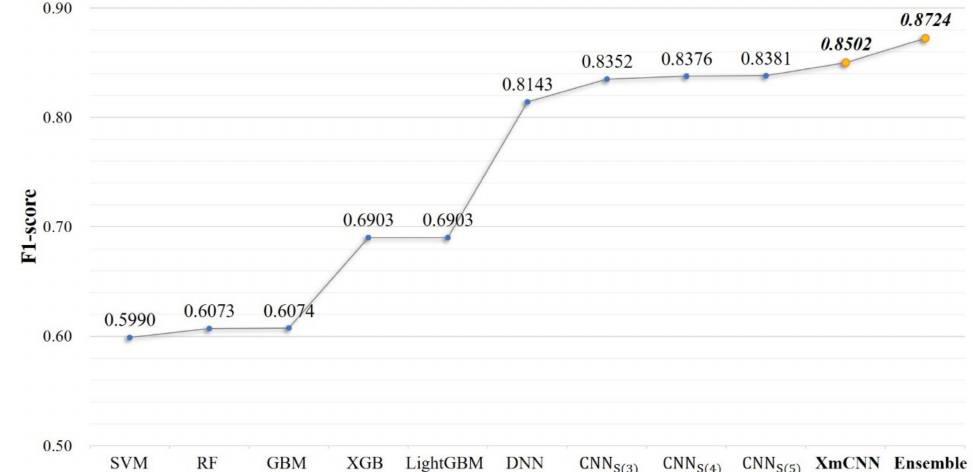
Figure 9. F1-score comparison of the overall models. Ensemble indicates Ensemble ( CNN S ( 3 ) , CNN S ( 4 ) ,CNN S ( 5 ) , XmCNN )